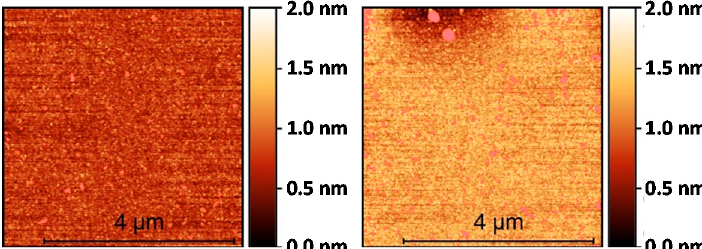
Figure 8. Atomic force microscope (AFM) topography characterization of ( left ) the bare SOI surface and ( right ) the SOI surface after TEVS silanization. A very low roughness (in the sub-nm range) is measured for both surfaces.